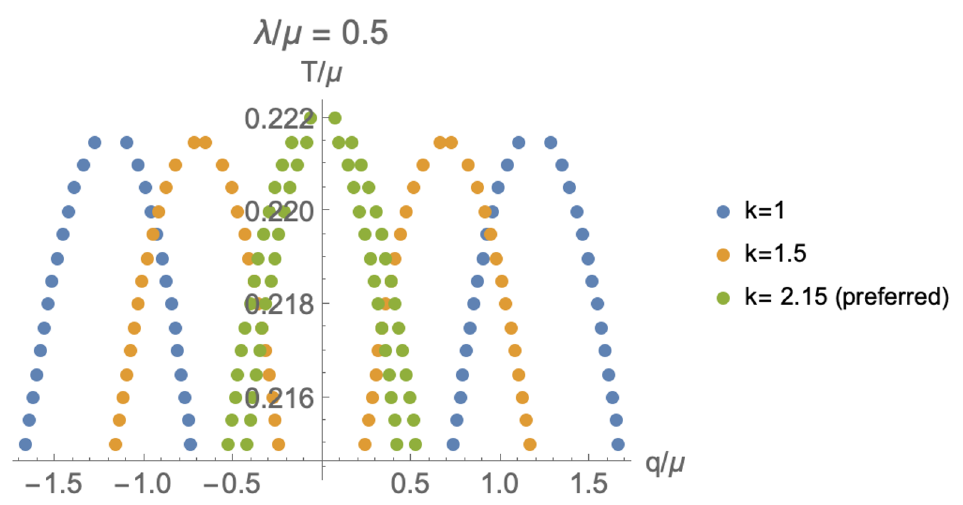
Figure 12. Marginal modes on the ( q, T ) plane for different values of the helical pitch. Close to the preferred pitch k ∼ p = 2 . 18 µ the primary and secondary instabilities lie on top of each c other, which accounts for the structure of the QNMs in the broken phase, shown on figure 8. All backgrounds have λ/µ = 0 . 5